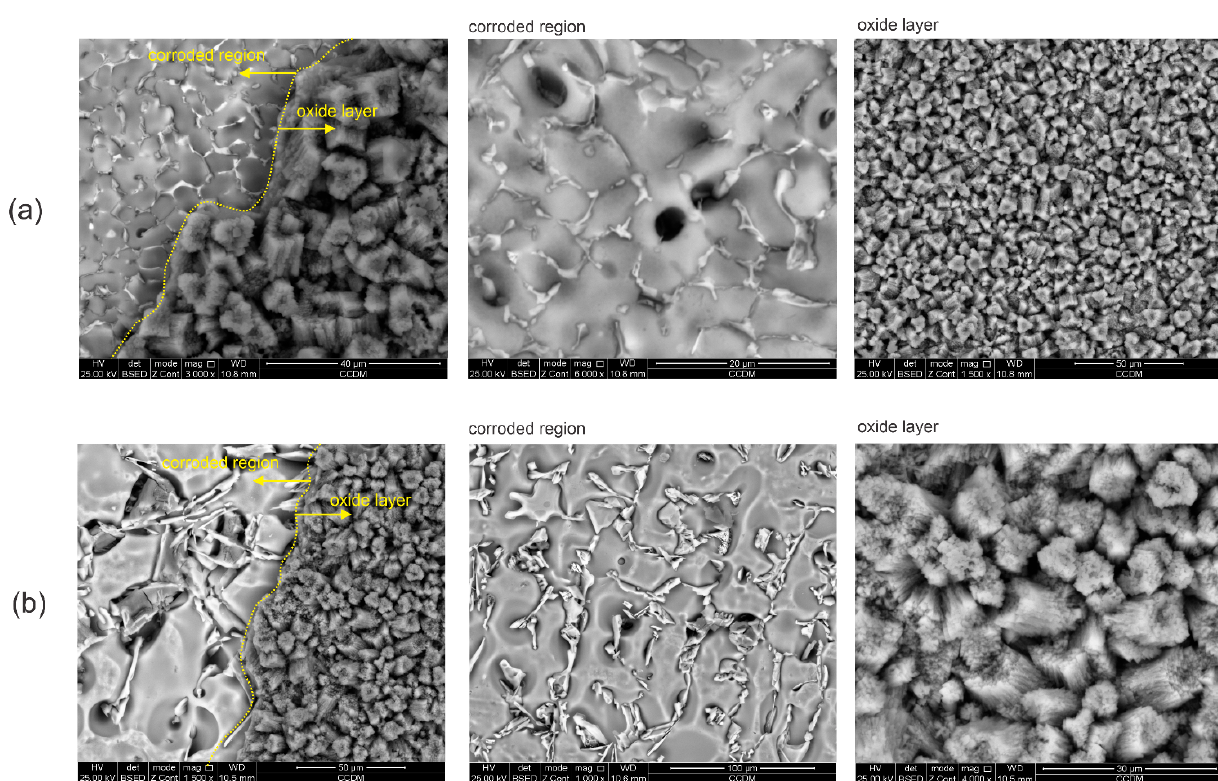
Figure 12. SEM images detailing either corroded or oxide layer regions formed after 30-day immersion experiments with the ( a ) CC and ( b ) DS Al-7%Si-0.6%Fe-0.35%Cu-0.25%Zn-0.5%Ni alloy samples in 0.6 M NaCl.